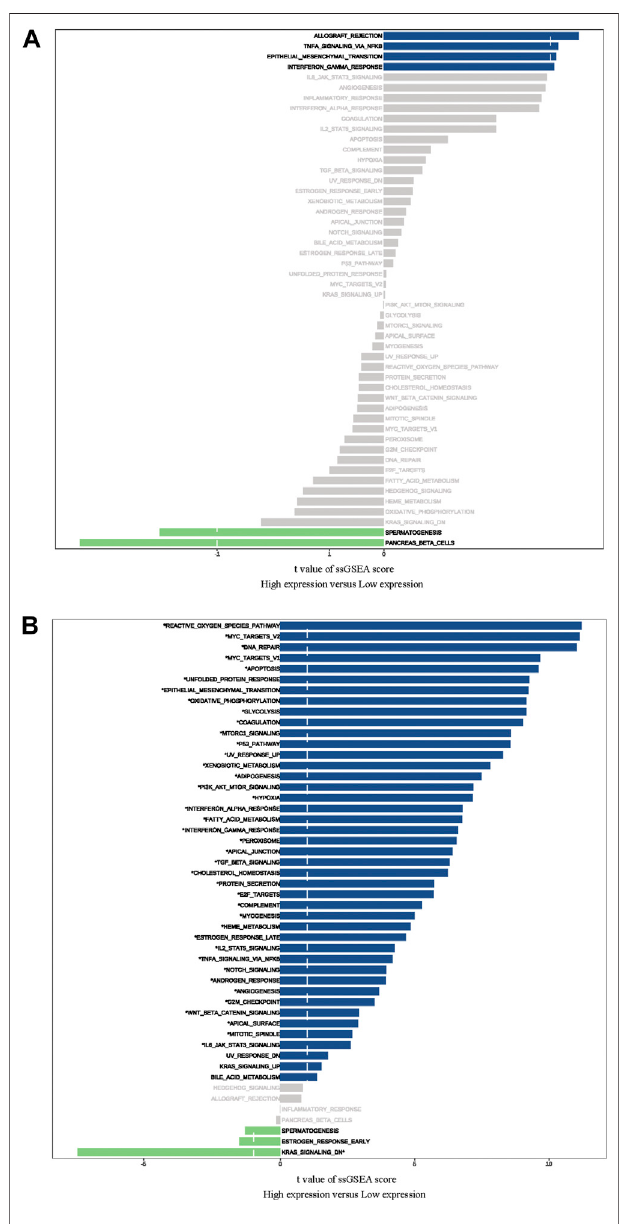
FIGURE 8 | Difference of Hallmark gene set in high- and low-RCN1 groups. (A) TCGA. (B) CGGA.